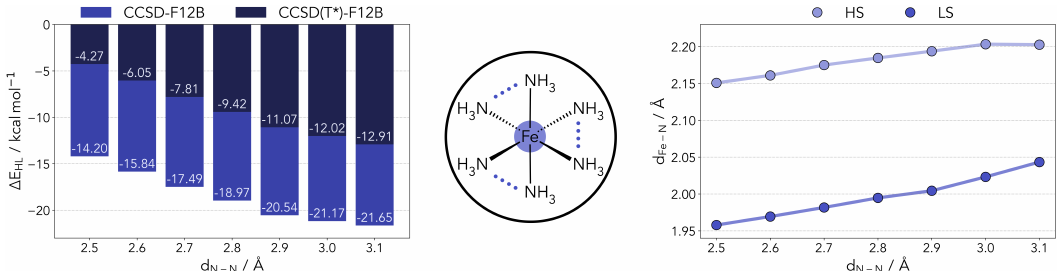
Figure 1. Left panel: Computed HS-LS gap for the [Fe II (NH 3 ) 6 ] 2 + complex with varying N-N distances at the coupled cluster level (including the DK correction and the scaled triples). Center panel: Diagram of the model complexes used in the benchmark. The N-N distances were restricted pairwise with all other geometry parameters being optimized for both HS and LS states. Right panel: variation in the Fe-N distance as a function of the restraint placed on the